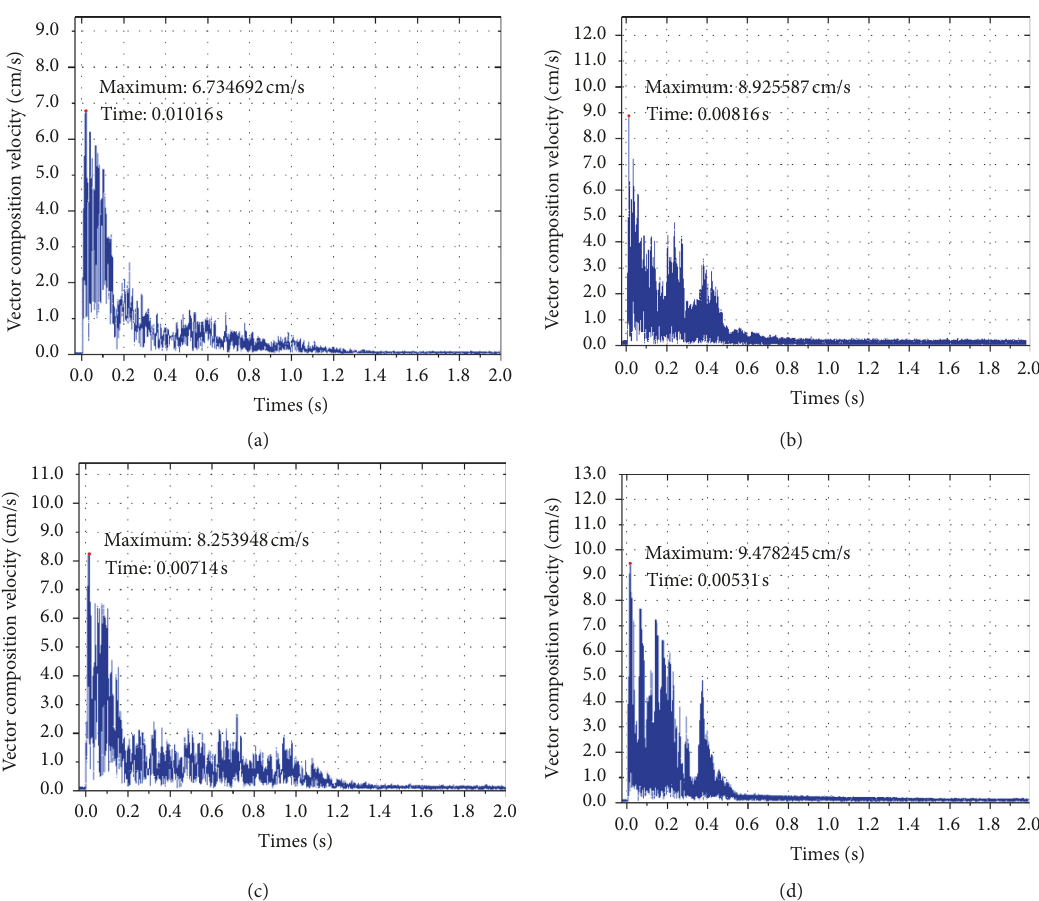
Figure 4: Time-history curve of vibration velocity at Point A during blasting of Section I (a), Section II (b), Section III (c), and Section IV